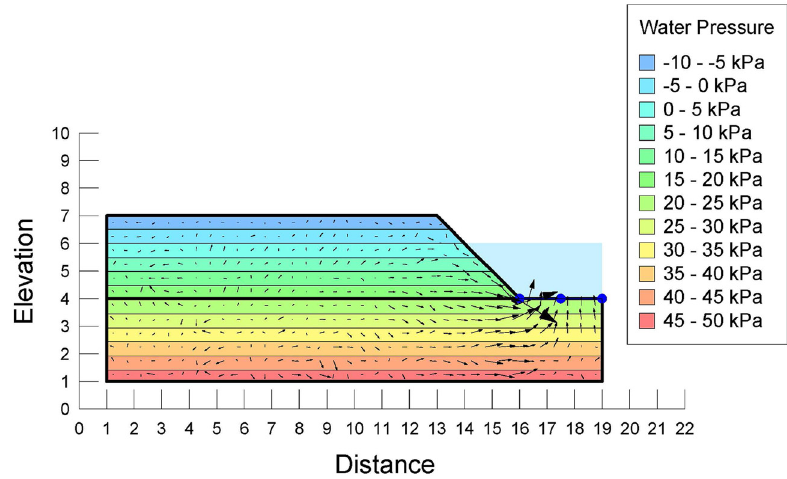
Figure 5: Steady state seepage ( SEEP/W ) before applying rationing system.